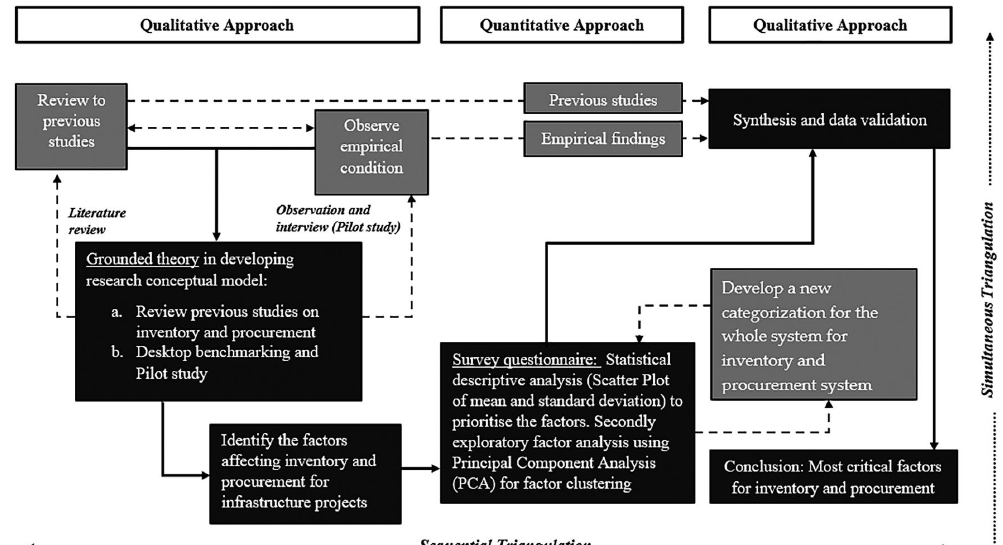
Figure 2. Research